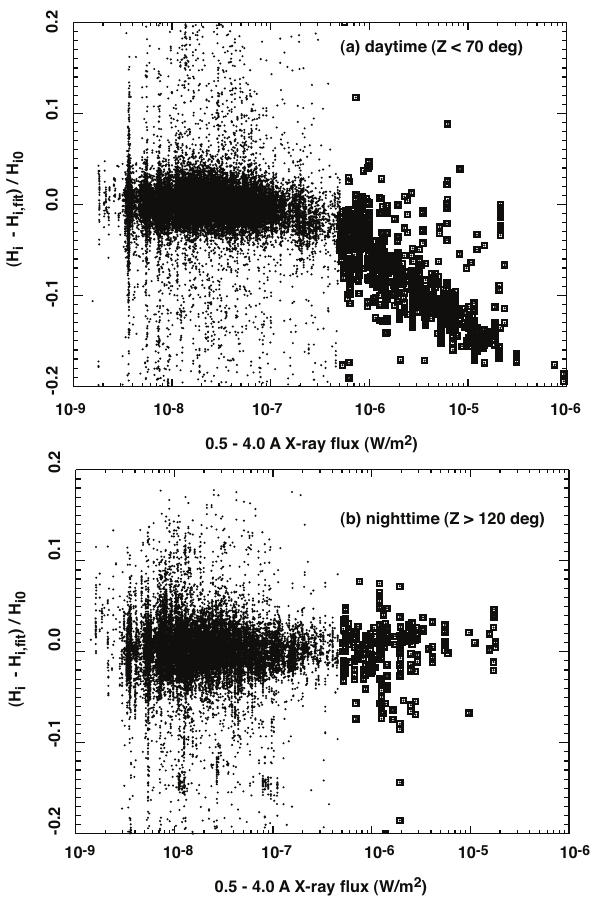
Fig. 9. Similar to Fig. 8, but plotted versus short-wave X-ray flux density.